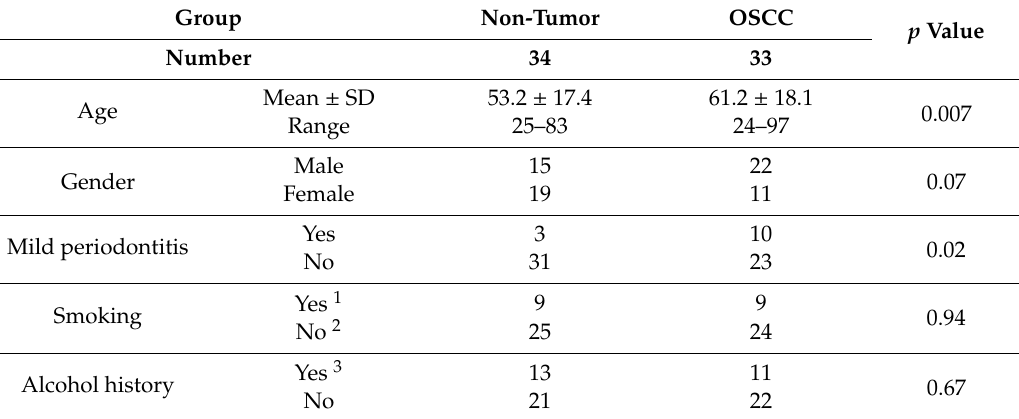
Table 1. Subjects participated in this